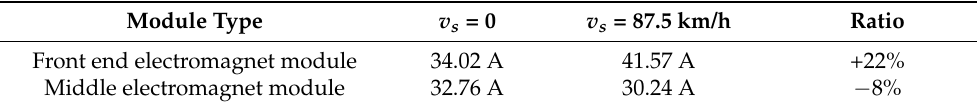
Table 4. Measured excitation current of